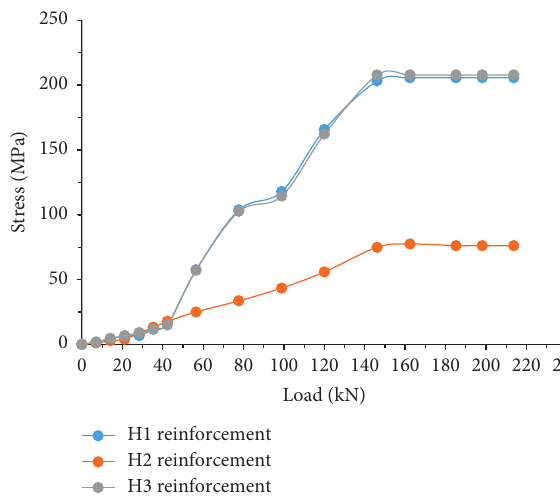
Figure 36: Strain/load curve of truss reinforcement.